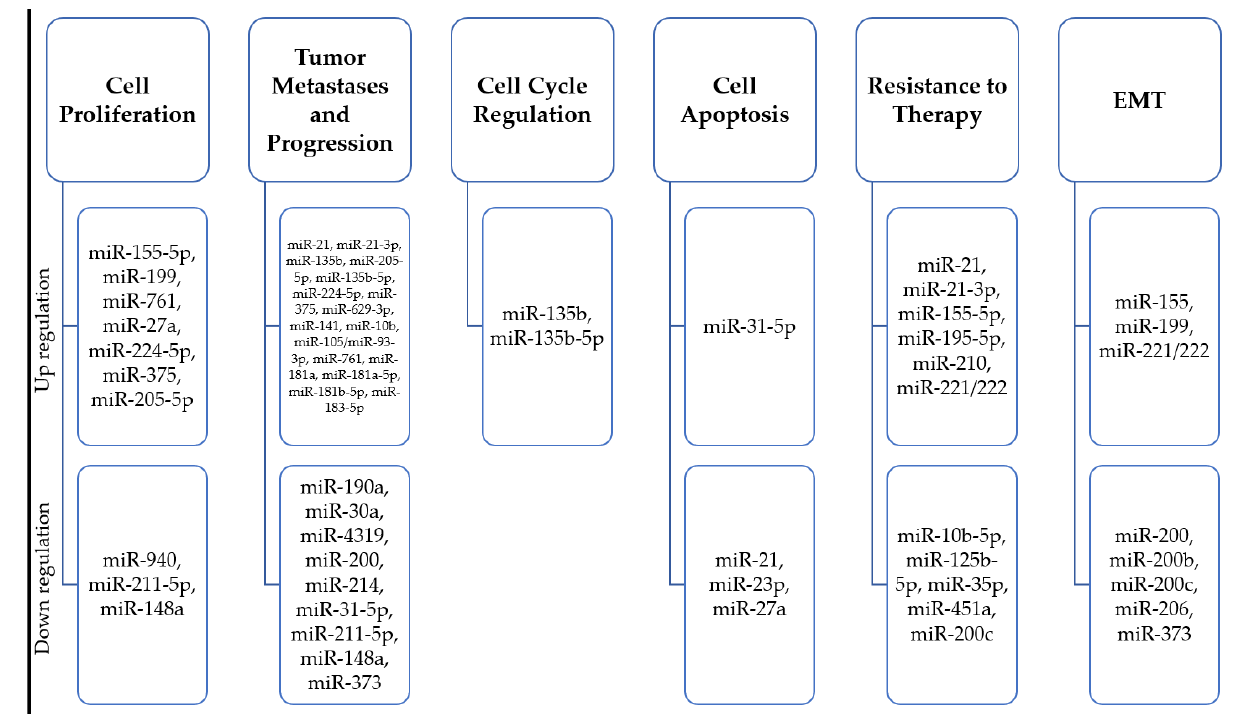
Figure 2. Summary of microRNA molecules characteristic of different stages of progression of hereditary and familial breast cancer.